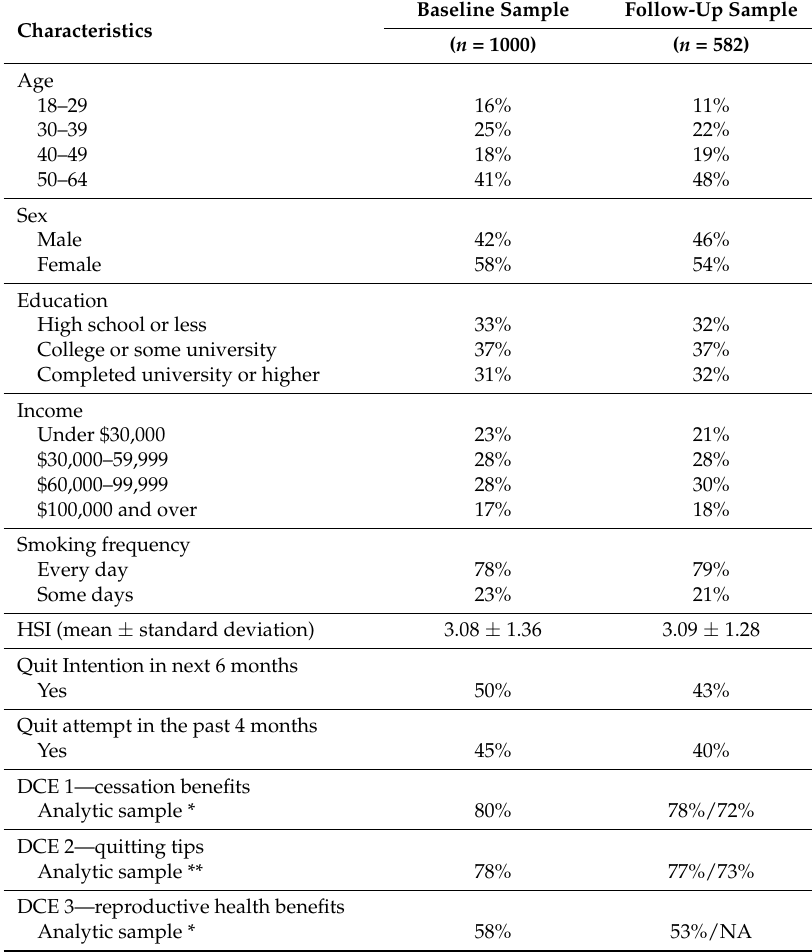
Table 1. Characteristics of study